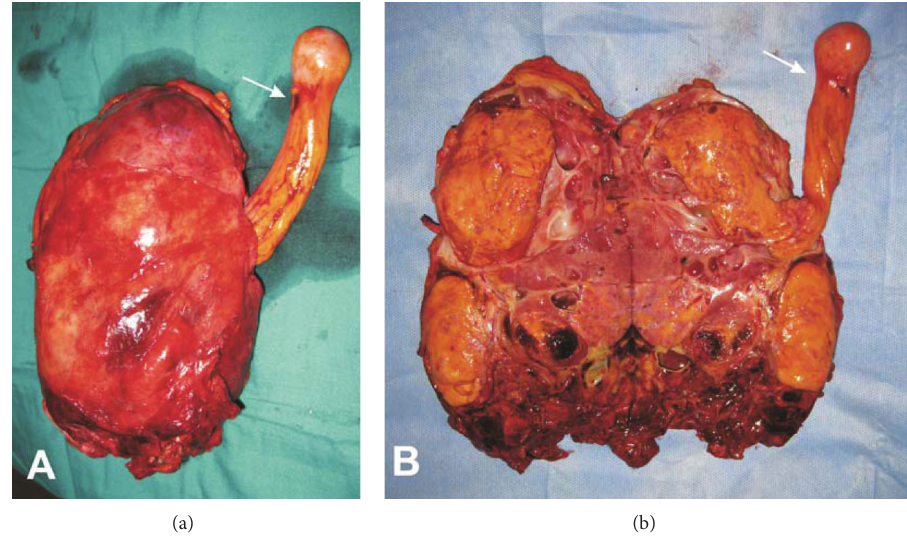
Figure 2: (a) Operative specimen showing the renal AML with the fatty thrombus extended from it. (b) Opened specimen showing the fatty thrombus in continuity with the AML. Note the notch in the distal part of the thrombus corresponding to the intracardiac passage